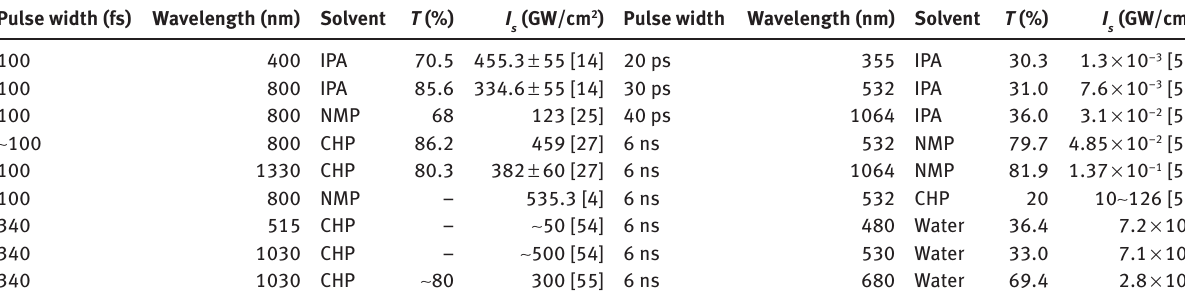
Table 1: Saturation intensity of black phosphorus (BP) nanosheets under different pulse widths and solvents. Pulse width (fs) Wavelength (nm) Solvent T